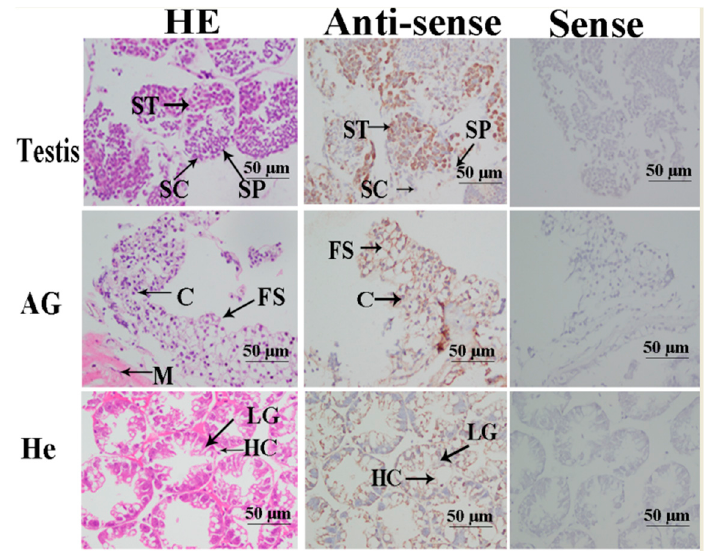
Figure 5. Location of the GEM gene was detected in testis, androgenic gland, and hepatopancreas of M . nipponense by using in situ hybridization. Testis, androgenic gland, and hepatopancreas were sampled at reproductive season. AG: androgenic gland; ST: spermatid; SC: spermatocyte; SP: sperm; M: muscle; C: androgenic gland cell; FS: funicular structure; He: hepatopancreas; LG: lipid granules; HC: hepatocytes. Scale bars = 50 μ m.